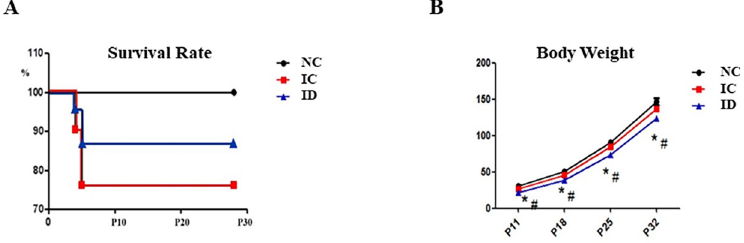
Fig 2. Survival rates and changes in body weight. There were no significant differences in survival among the groups. The survival rate of the IVH + dexamethasone (ID, n = 21), the IVH control (n = 21), and the normal control (NC, n = 9) were 86%, 71%, and 100%, respectively (A). ID group (n = 18) group had the smallest weight gain between P11 to P32. NC group (n = 9), IC group (n = 15) (B). IVH refers to intraventricular hemorrhage. � P < .05 compared to NC group. # P < .05 compared to IC group.